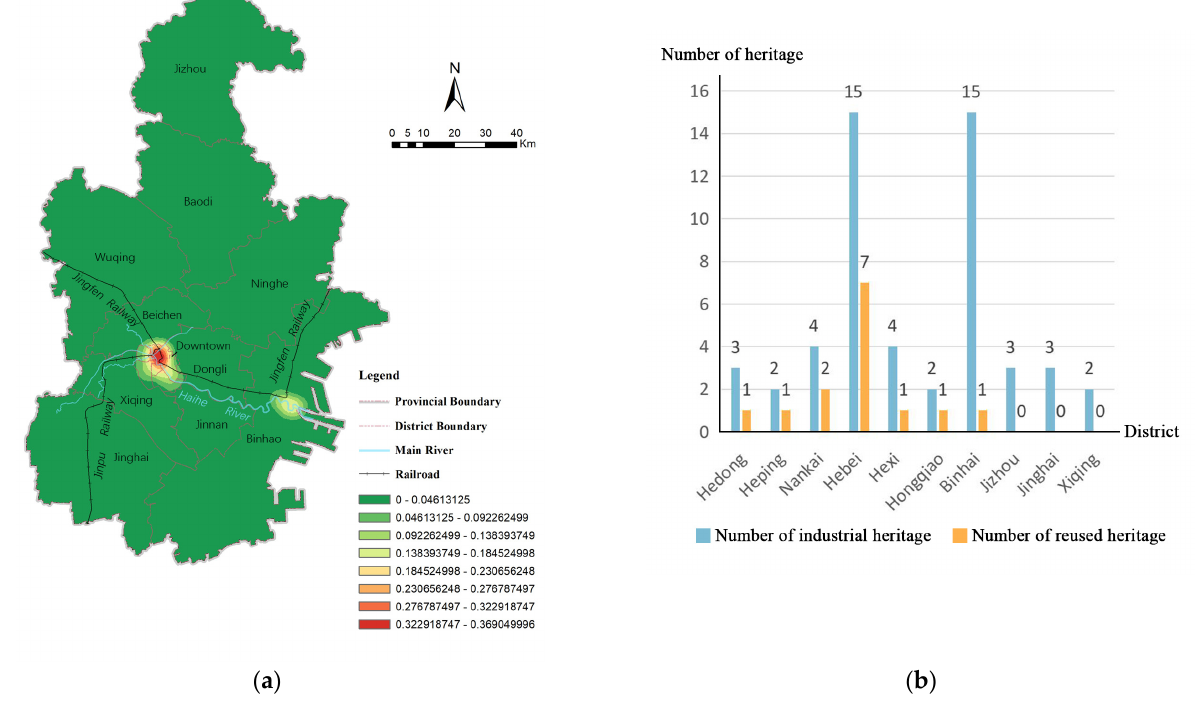
Figure 10. ( a ) Analysis of the kernel density of plant-type industrial heritage in Tianjin; ( b ) statistics on the total amount of plant-type industrial heritage sites and the amount of their reuse in Tianjin by